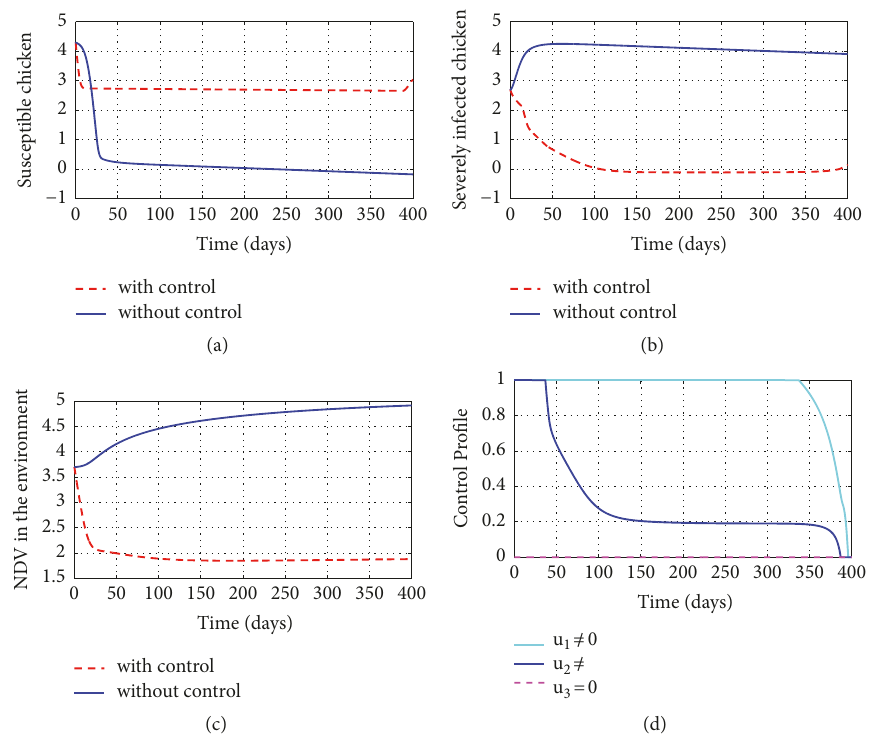
Figure 4: Optimal solutions for model variables 𝑆 𝑐 , 𝐼 𝑐 , 𝐻 and the control profiles for 𝑢 1 , 𝑢 2 , 𝑢 3 with ( 𝑢 1 ̸= 0 , 𝑢 2 ̸= 0 , 𝑢 3 = 0